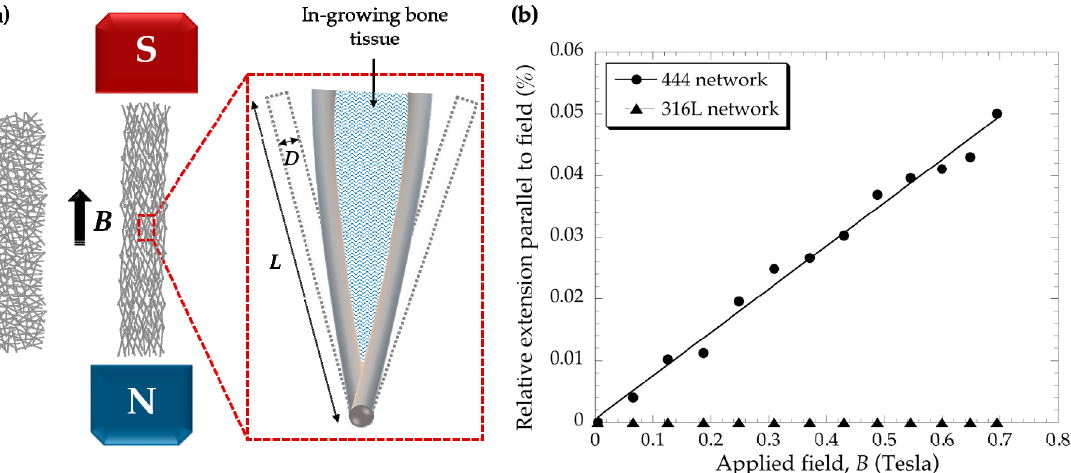
Figure 1. ( a ) Schematic representations of the elastic deformation of a fiber network under a magnetic field B . Also shown is the deflection of a bonded pair of fibers deforming in-growing bone tissue. ( b ) Representative relative net extension in the direction of the applied field as a function of the applied magnetic field B for 444 and 316L fiber networks (rectangular beam sample clamped at one end).